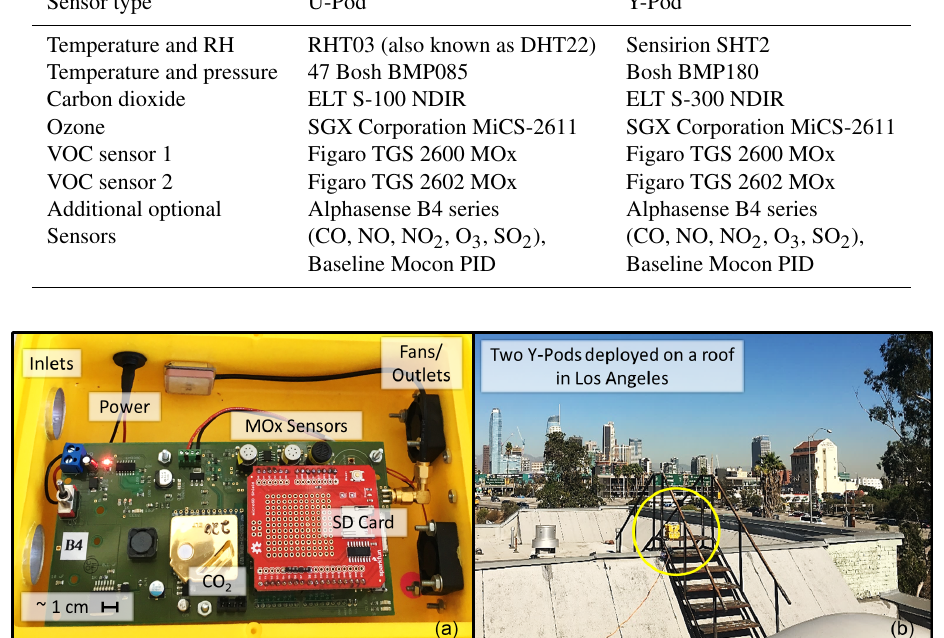
measurements taken at the Golden National Renewable En- ergy Laboratory (NREL), Frederick, and Platteville. All Col- orado sites are shown in Fig.